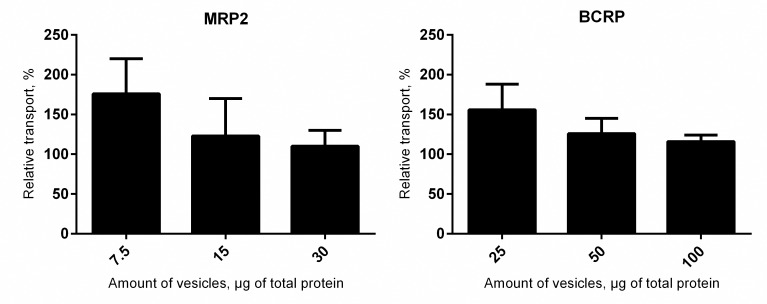
Relationship between the albumin effect and amount of vesicles used in the assay.Transport activity with varying amount of vesicles (measured as total protein in μg per well) were examined in the presence and absence of 0.1% BSA. Substrate concentrations in the assay were (left panel) 50 μM for CDCF (MRP2 vesicles) and (right panel) 200 μM for Lucifer Yellow (BCRP vesicles). Data is expressed as relative transport, normalized to the ATP-dependent uptake in the absence of BSA. Each bar represents the mean (± SD), n = 3–6.